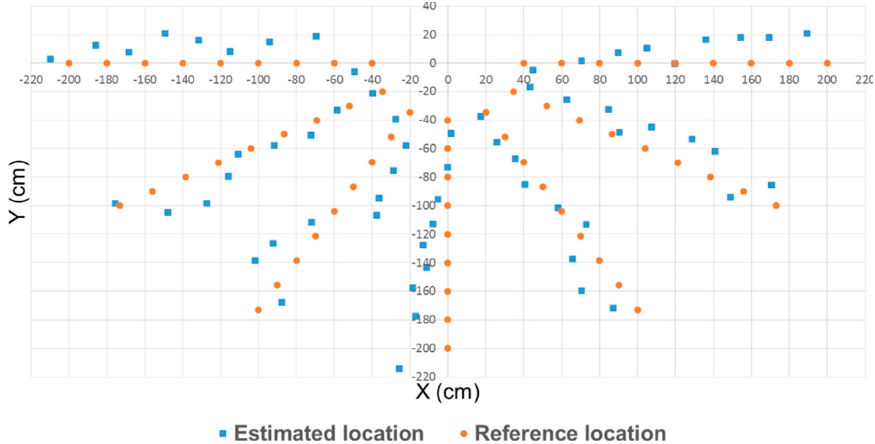
Figure 19 . Result of relative-location recognition using IR signal intensity. Figure 19. Result of relative-location recognition using IR signal intensity.